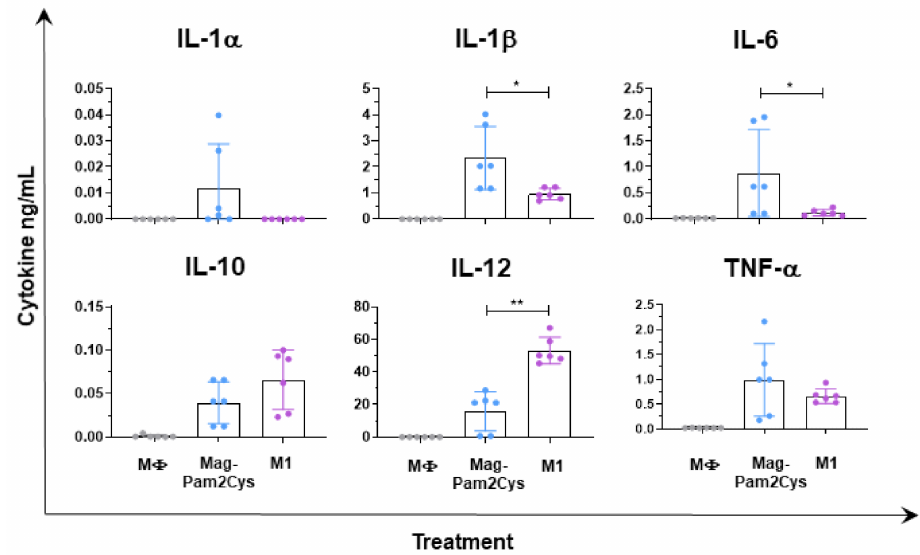
Figure 6. Cytokine release from moM Φ stimulated with Mag-Pam2Cys or IFN- γ and LPS. Porcine moM Φ were left untreated (M Φ ) or stimulated with Mag-Pam2Cys (100 ng/mL) or IFN- γ + LPS (M1). At 24 h post-stimulation, levels of IL-1 α , IL-1 β , IL-6, IL-10, IL-12, TNF- α in culture supernatants were quantified using a multiplex ELISA. Mean data and SD from three independent experiments using different blood donor pigs are displayed. Values of Mag-Pam2Cys-treated samples were compared to bona fide moM1 (M1), using a Mann–Whitney test. ** p < 0.01, * p <